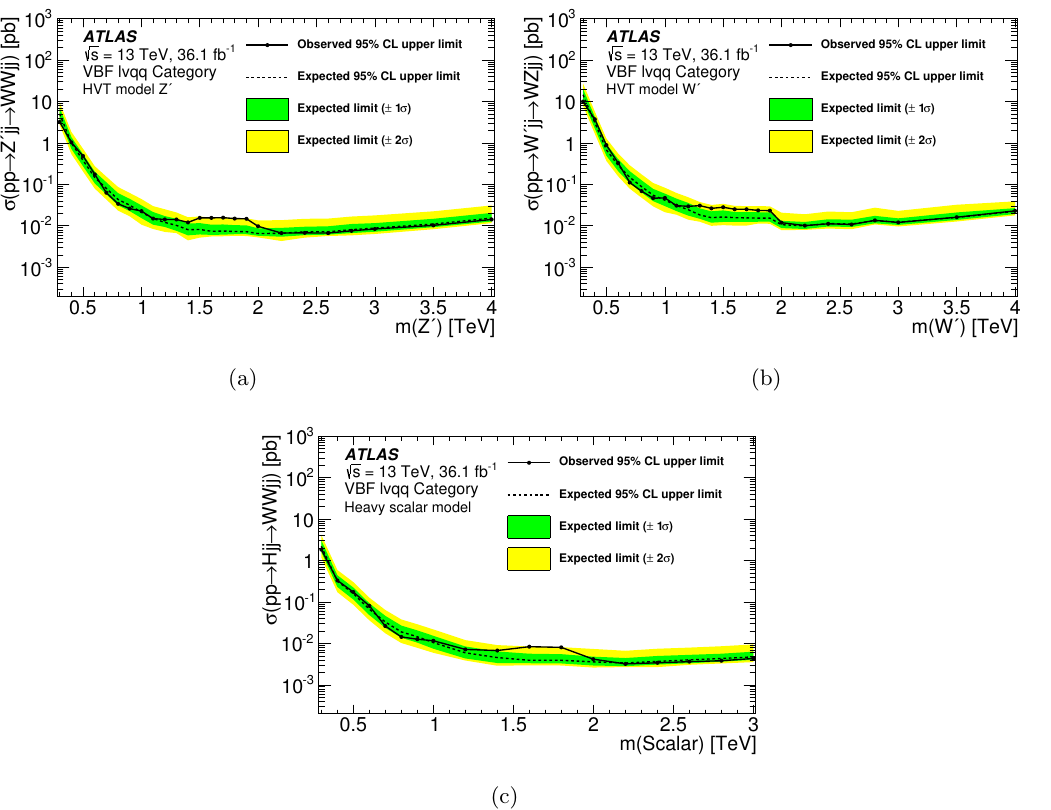
Figure 6 . The observed and expected cross-section upper limits at the 95% con(cid:12)dence level for WV production in the VBF category are presented as a function of the resonance mass. The dots in the observed limit curve represent the generated resonance mass values. Interpretations for (a) HVT Z 0 , (b) HVT W 0 and (c) heavy scalar signals, H , produced via VBF are shown. The mass region greater than 1500 GeV is covered by two bins in m ( WV ).